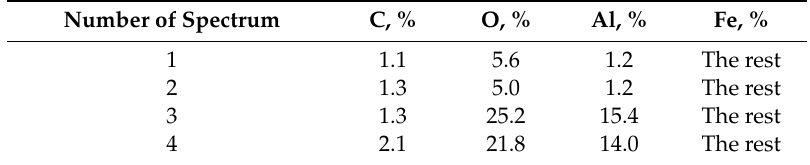
Table 2. Results of the SEM analysis of the fractural submicroarea of FeGr1 + 1 wt% of alumina. Number of Spectrum